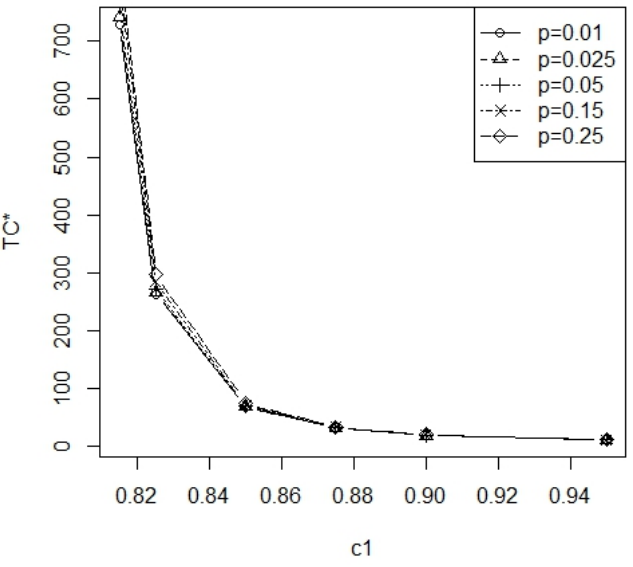
Figure 5. The minimum total cost for p = 0.01, 0.025, 0.05.